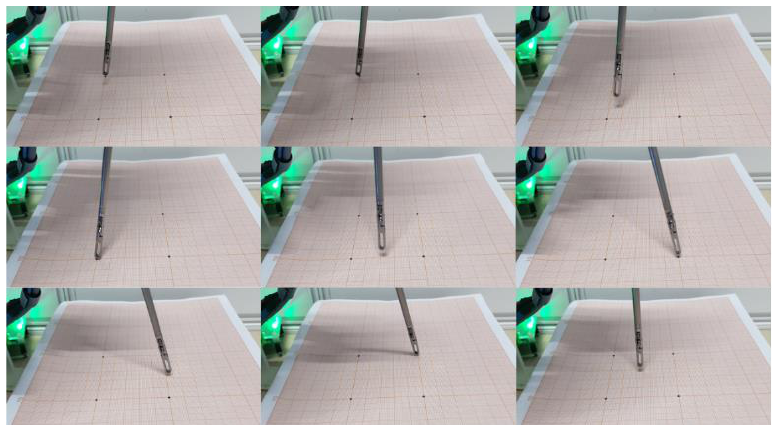
Figure 11. Tracking experiment process.